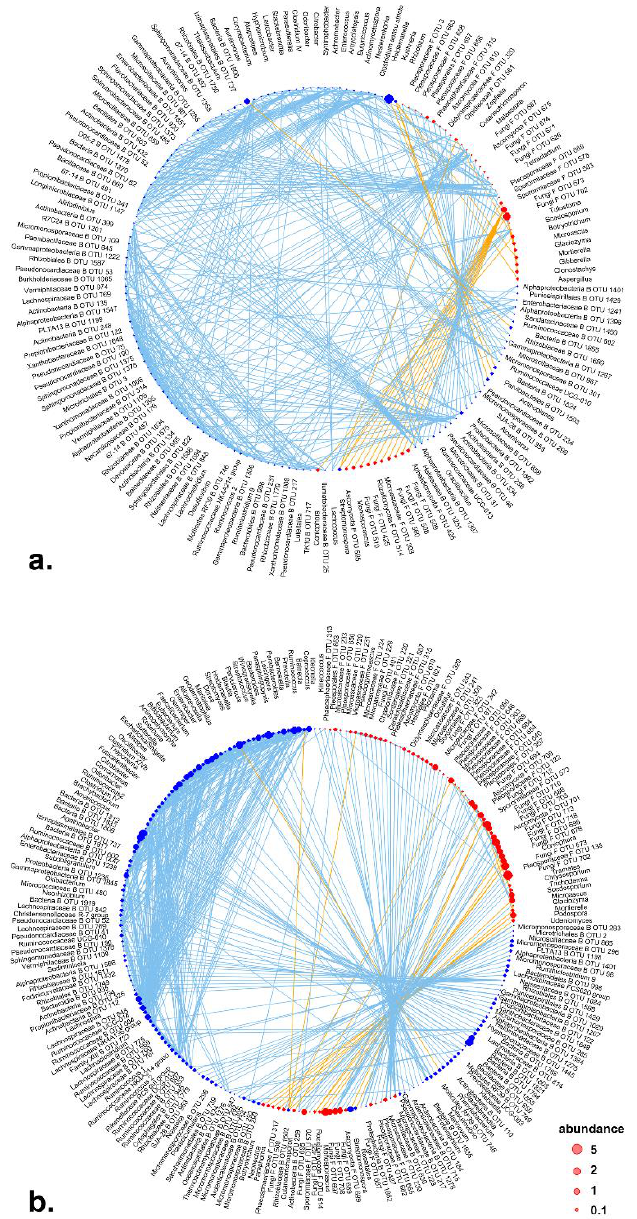
Figure 4. Co-occurrence network generated with endophytic bacterial and fungal genera generated at genus level for community of aerial tissues ( a ) and community of roots ( b ). Blue vertices indicate bacterial genera, red fungal genera, sky blue edges indicate positive correlations, and orange edges indicate negative correlations. Abundance was represented with normalized read counts using Hellinger transformation. All correlations were significant at p < 0.001 level, and with rho values in top 10% (for positive correlations) and bottom 10% (for negative ones) out of all rho values among correlations with statistical significance. Table 2. Network characteristics of bacterial and fungal co-occurrence networks in aerial tissues and roots.